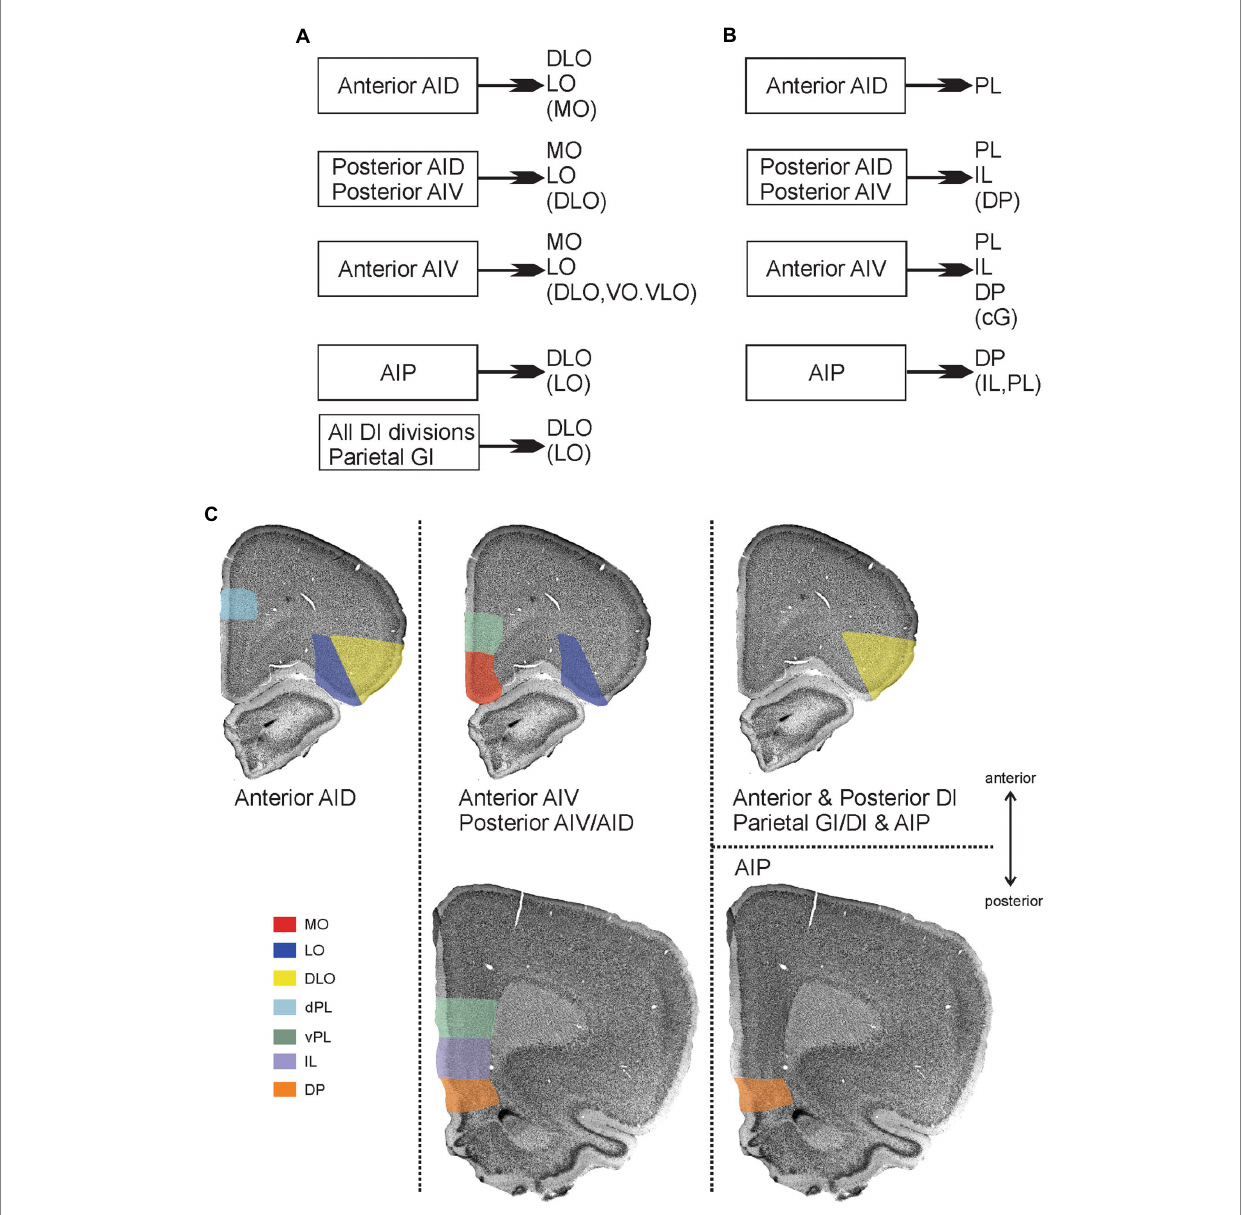
FIGURE 11 Main patterns of projections from insular cortex to orbitofrontal and medial prefrontal cortex. (A) Schematic diagram summarizing projections from distinct insular fields to the orbitofrontal cortex. (B) Schematic diagram summarizing projections from distinct insular fields to the medial prefrontal cortex. In both A and B, weaker projections are listed within brackets. (C) Visualization of the projections to orbitofrontal and medial prefrontal cortices, including the more detailed dorso-ventral and anterior–posterior organization of projections to the medial prefrontal areas. Termination of insular fiber pathways in the orbitofrontal and medial prefrontal cortex are indicated by a specific color for each orbital field that receives dense projections (shown in A,B ). The anterior dorsal agranular insular field (anterior AID) targets the dorsolateral (DLO) and lateral (LO) orbital fields as well as the dorsal portion of the prelimbic cortex (dPL), specifically at rostral levels. The anterior ventral agranular field (anterior AIV), in contrast, targets lateral orbital (LO), medial orbital (MO), ventral prelimbic (vPL) anteriorly, and vPL, infralimbic (IL), and dorsal peduncular cortex (DP) at more posterior levels. These same areas are receiving inputs from both posterior agranular fields (posterior AIV/AID) The agranular parietal insular field (AIP) targets more specifically the dorsolateral (DLO) field and the dorsal peduncular cortex (DP). Finally, all the dysgranular portions, as well as the parietal granular field, provide a projection that is restricted to the dorsolateral field (DLO), avoiding mPFC